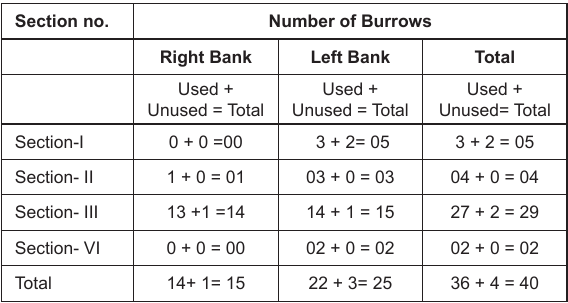
Table 2. Numbers of burrows observed in study area, River